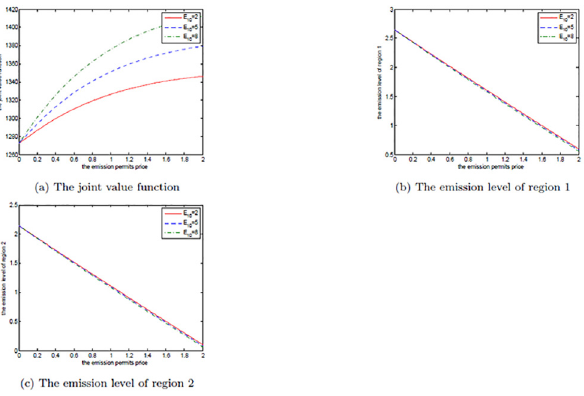
Fig 15. The effects of E 10 on the cooperative game.